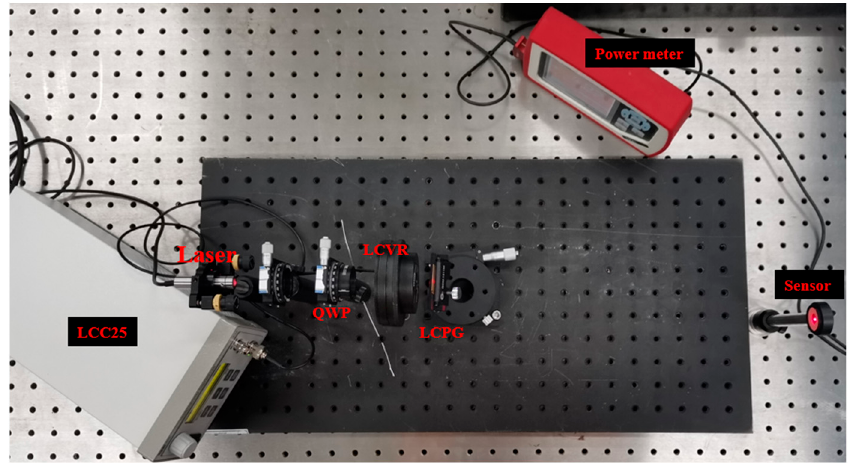
Figure 9. Diagram of the experimental apparatus. Table 3. Basic parameters of the experimental device.